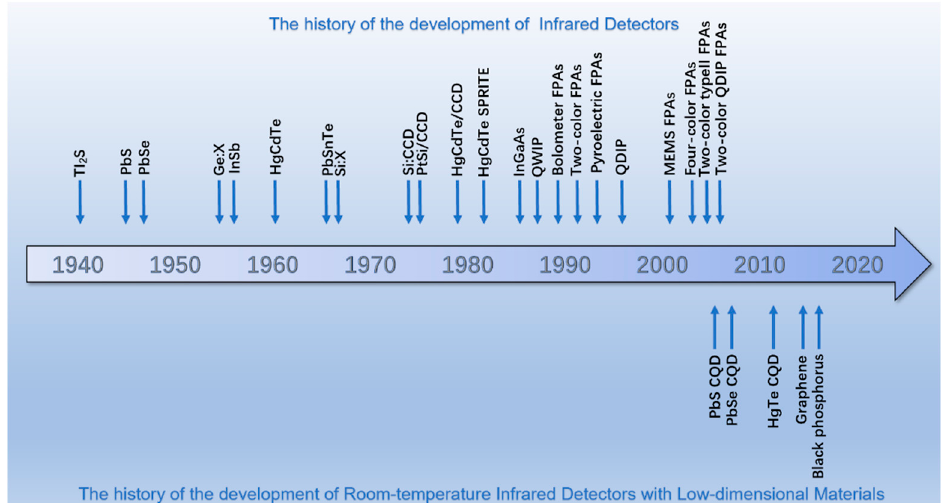
Figure 1. “The history of the development of infrared detectors” and “The history of the development of room-temperature infrared detectors with low-dimensional materials”. Low-dimensional materials can be classified into zero-dimensional (0D), one-dimen- sional (1D) and two-dimensional (2D) materials.